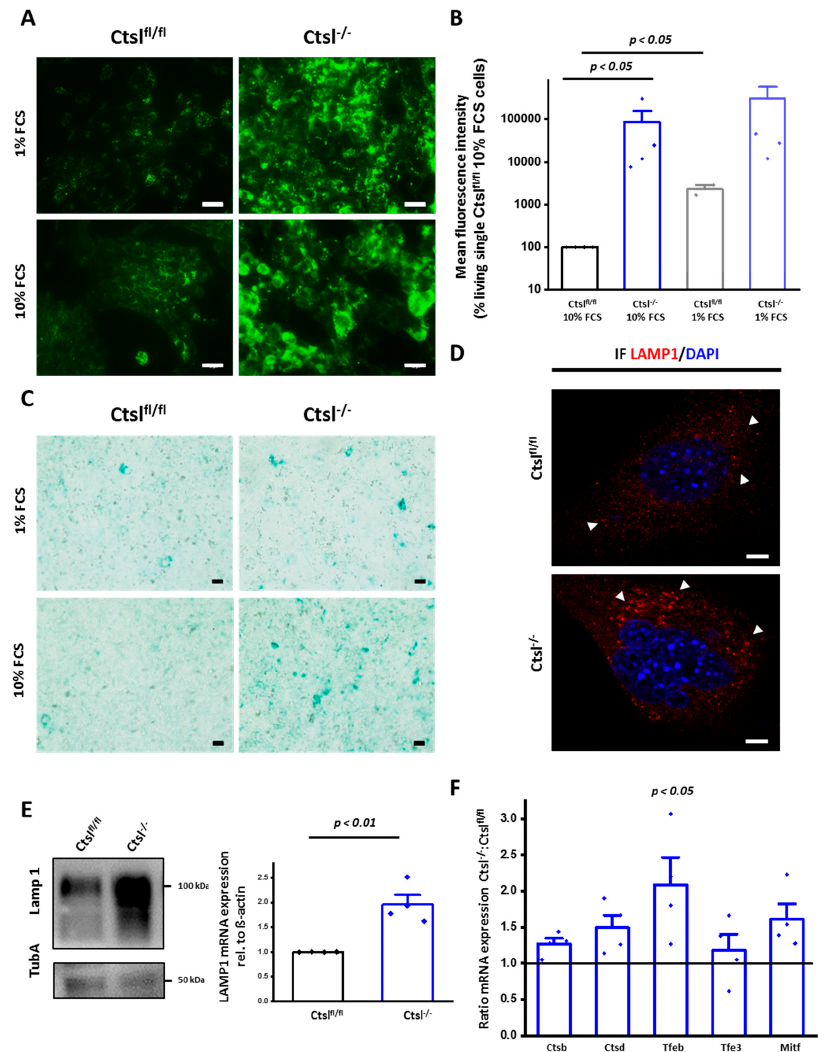
Figure 6. Enlargement and accumulation of acidic vesicles in Ctsl-deficient cells. ( A ) Fluorescence microscopy images of Ctsl fl / fl and Ctsl − / − mammary epithelial cancer cells in 3-day cultures under 10% and 1% FCS stained with LysoTracker TM reveal the enlargement of the lysosomal compartment (Scale bar: 50 µm). ( B ) LysoTracker TM mean fluorescence quantification by flow cytometry at standard culture conditions (10% FCS) show a significant increase in green fluorescence consistent with microscopy images. LysoTracker TM positive staining increases under nutrient deprivation conditions (1% FCS) ( n = 4) ( p < 0.01, ANOVA, Tukey post-hoc test); mean ± S.E.M. ( C ) Bright field microscopy images of Ctsl fl/fl and Ctsl − / − mammary epithelial cancer cells in 3-day cultures under 10% and 1% FCS stained with β Galactosidase (Scale bar: 100 µm). ( D ) Confocal microscopy images of LAMP1 stained as a marker for lysosomes. DAPI was used as nuclear counterstaining (Scale bar: 5 µm). ( E ) Western blot identification of LAMP1 showing its enrichment in Ctsl − / − cells. Tubulin A was used as a loading control. Quantification of mRNA expression of LAMP1 relative to mRNA expression levels in Ctsl fl/fl and Ctsl − / − epithelial breast cancer cells. ( F ) mRNA expression quantification of lysosome-related genes, showing increased transcription of the proteases Ctsb and Ctsd, together with an increase of transcripts of the MiT / Tfe transcription factor family, triggers of lysosomal biogenesis, (one-way ANOVA, Tukey post-hoc test) ( n = 4); mean ±